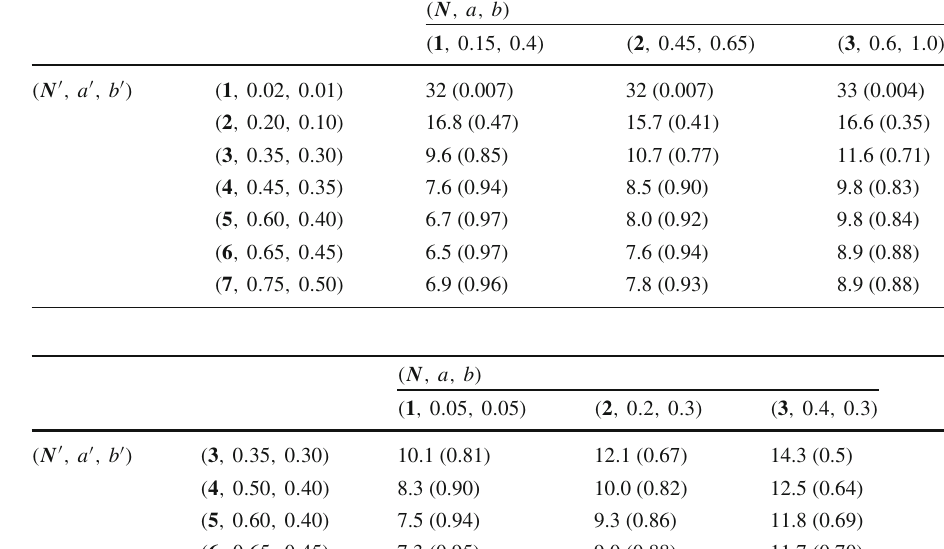
Table 5 Simulation for the SU ( 5 ) model for the scenario with tan β = 40. We display the χ 2 of the physical couplings, corresponding to 15 degrees of freedom. The parentheses give the p value, the proportion of models with lower probability density (larger χ 2 ) than the SM